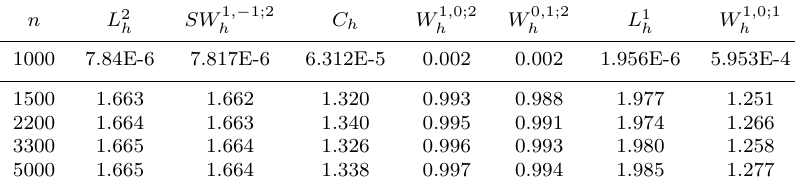
Table 5. Practical errors and error orders in Example A 5 / 2 n